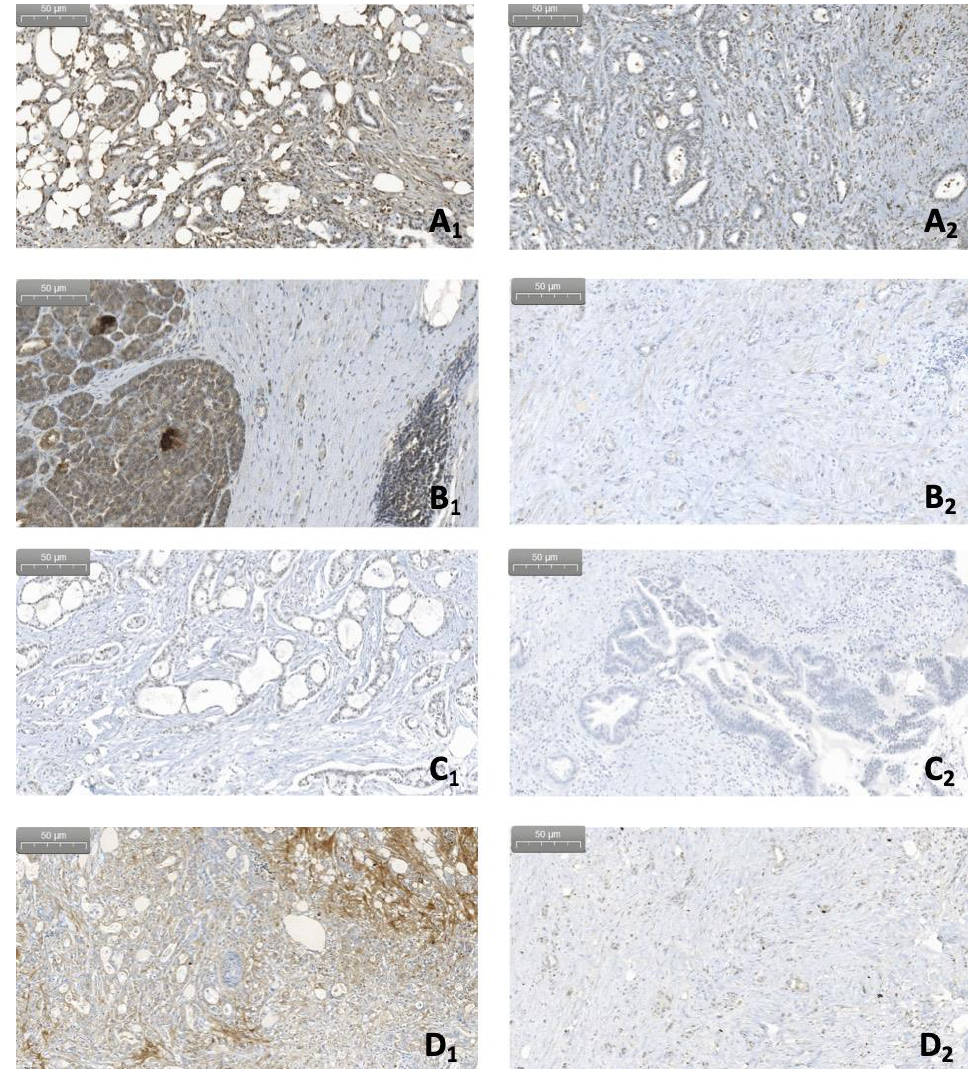
Figure 6. Immunohistochemistry. Comparison of the expression of different complement factors between specimens positive for Malassezia spp. DNA (letters labelled with number 1: A 1 , C 1 and D 1 correspond to PDAC samples, B 1 to chronic pancreatitis) and specimens where Malassezia spp. was not detected (letters labelled with number 2: A 2 , B 2 , D 2 depict PDACs and C 2 corresponding to intraductal papillary mucinous neoplasm, respectively). ( A ) expression of C1q; ( B ) expression of fB; ( C ) expression of MBL; and ( D ) expression of C3c (magnification 20×).